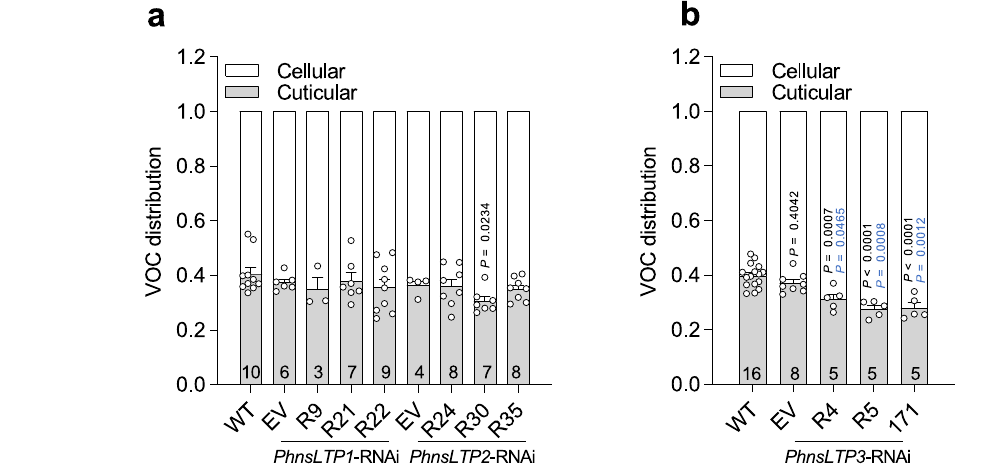
test relative to the WT (black) and EV (blue) controls. All data are means±S.E. Numbers at the bottom of the columns show the numbers of biological replicates. Absolute VOCs ’ amounts in cellular and cuticular fractions are presented in Sup- plementary Table